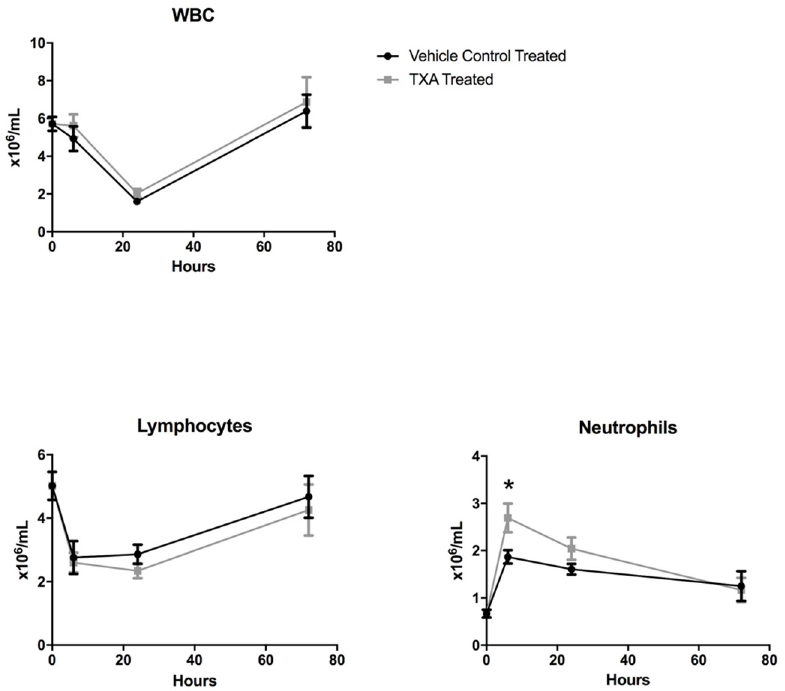
Fig 1. White blood cell (WBC) count with neutrophil and lymphocyte differentials in rats subjected to controlled hemorrhagic shock and resuscitation, vehicle control (normal saline) treated vs. tranexamic acid (TXA) treated, 300mg/kg ( � p < 0.05, error bars =